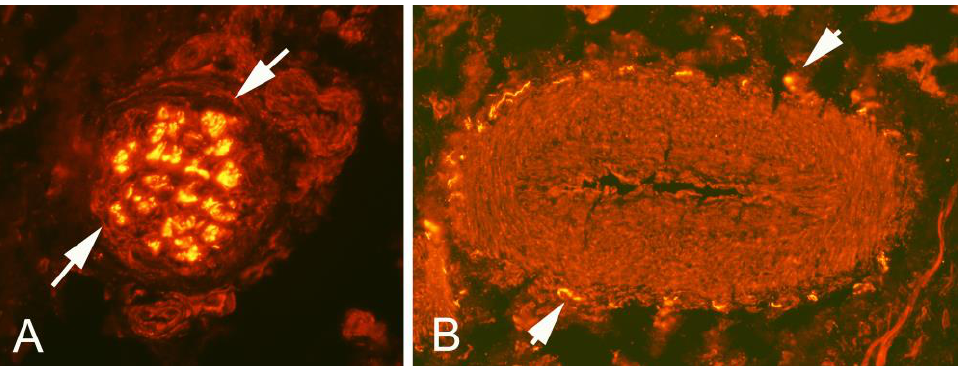
Figure 3. Sections of superficial side peritendinous tissue from the patellar tendon stained for general nerve (axonal) marker bIII tubulin. Nerve fibers were seen in nerve fascicles (( A ), arrows) and in close vicinity of blood vessels and perivascular spaces (( B ), arrow heads).